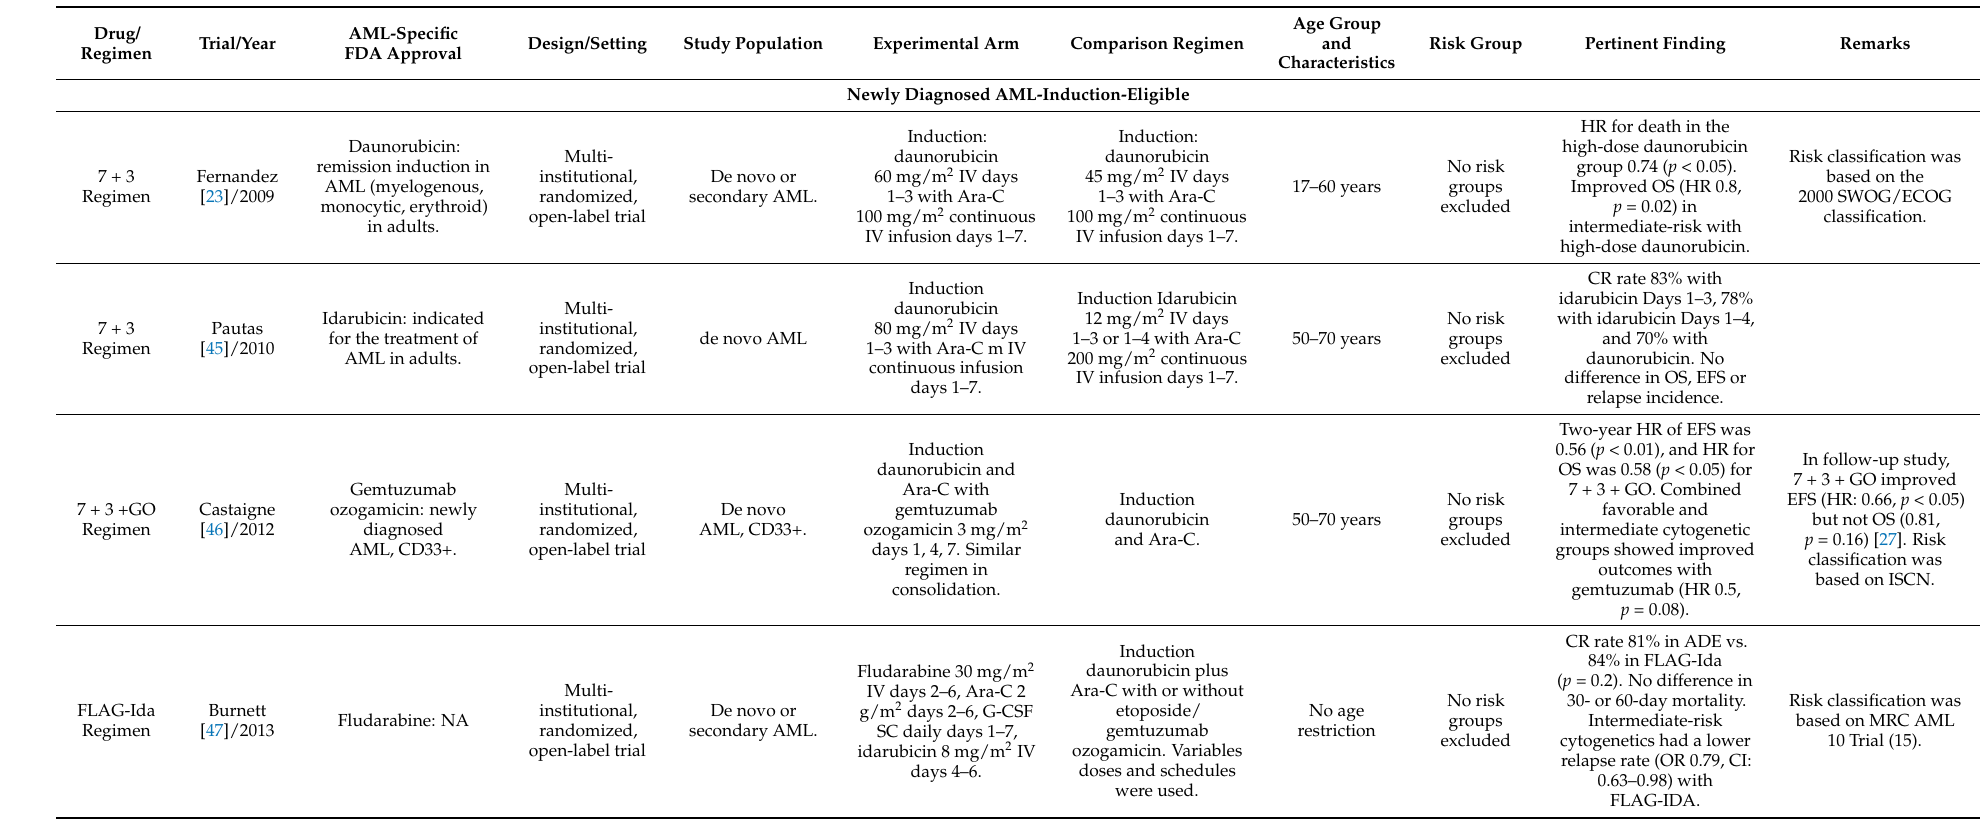
Table 3. Major therapeutic regimens and associated trials suggested in NCCN guidelines for intermediate-risk